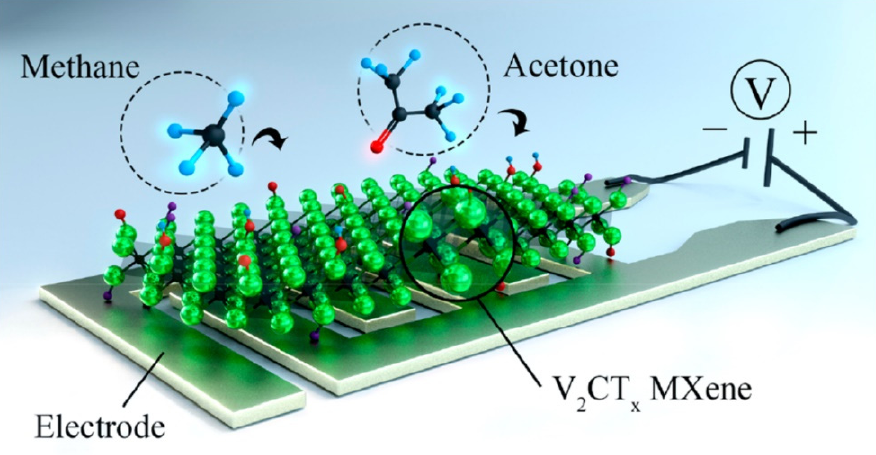
Figure 9. Schematic illustration of the possible sensing mechanism suggested for the V 2 CT x MXene based gas sensor. Reprinted with permission from [49]. Copyright © 2017, American Chemical Society.